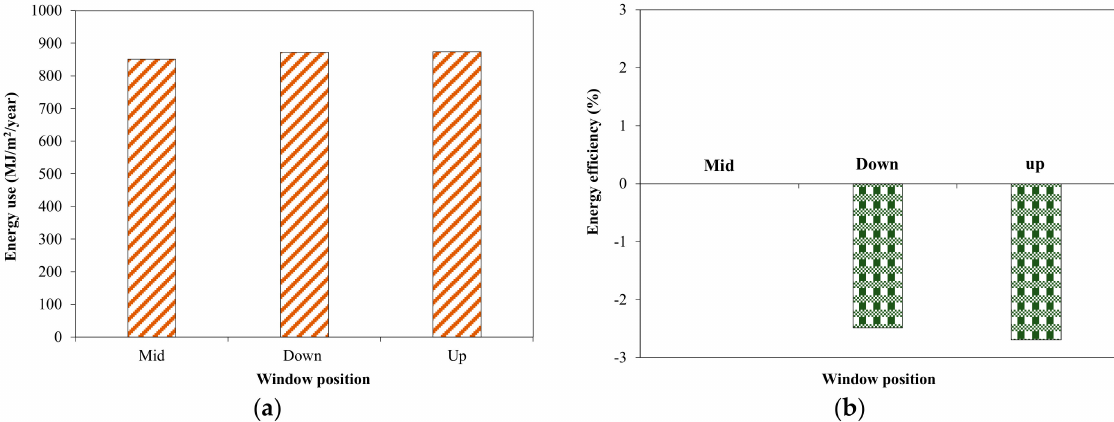
Figure 16. Effect of window position on energy use in tested office building. ( a ) Energy use; ( b ) Efficiency.